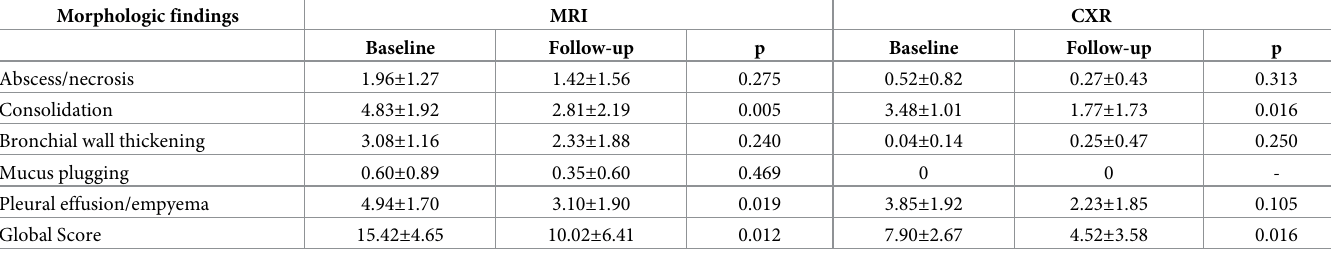
Table 7. Differences in scores for morphologic findings in MRI and CXR between baseline and follow-up. Morphologic findings MRI